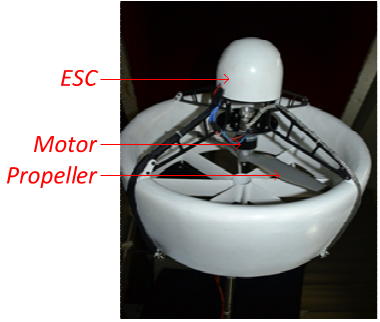
Figure 1. The prototype electric micro air vehicle (MAV); ECS: electronic speed controller.